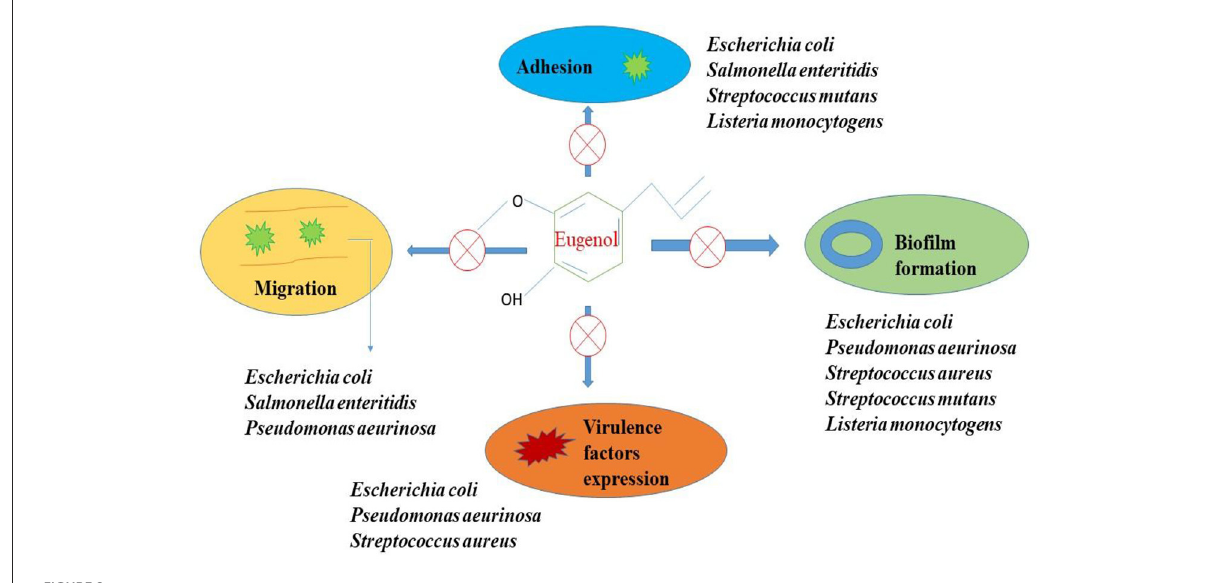
FIGURE2 Antibacterial mechanism of eugenol.